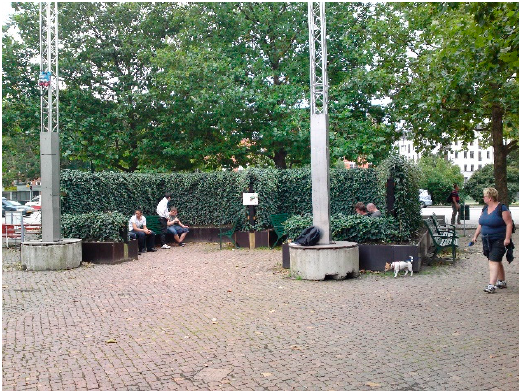
Figure 4. City of Malmö. A small arbor constructed from noise screens covered with ivy. Sounds of nature were added using concealed speakers and visitors’ experiences were evaluated [38]. Photo: Gunnar Cerwén.